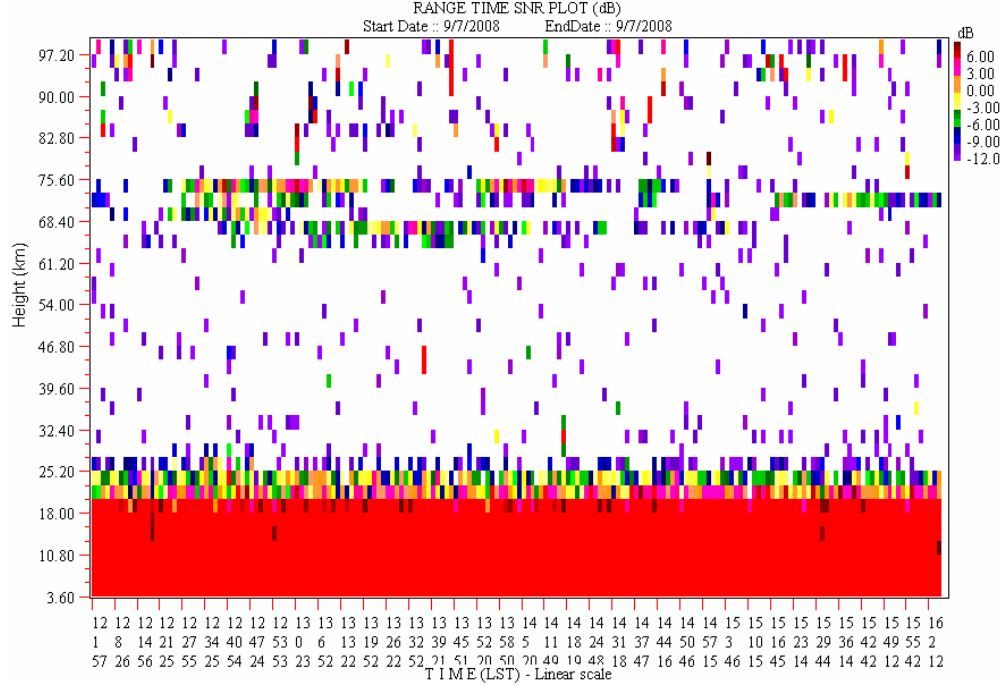
Fig. 5. Range-time SNR plot of mesospheric echoes observed by the MST radar (vertical beam) on 9 July 2008 over Gadanki.